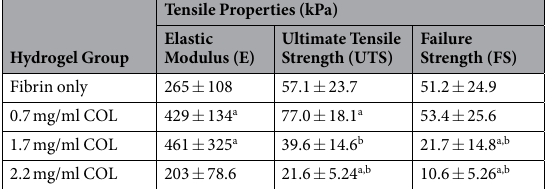
Table 2. Tensile properties of adventitia rings with differing hydrogel content. All groups were subjected to cytokine stimulation with TGF- β and ascorbic acid. Groups were defined in terms of percent of collagen gel (COL) in a base fibrin gel. a Denotes statistical significance to fibrin only (p ≤ 0.01); b Denotes statistical significance to 0.7 mg/ml COL (p ≤